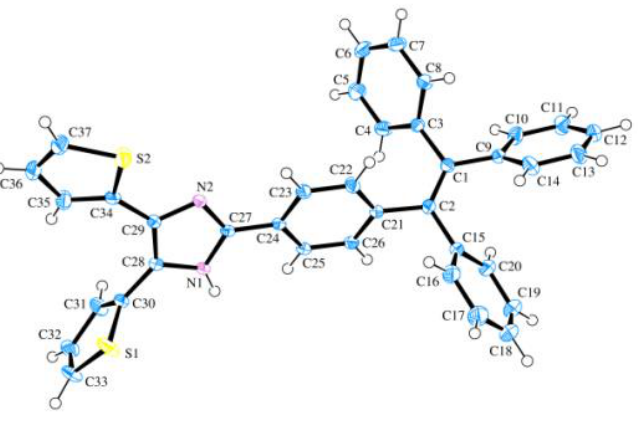
Figure 2. Molecular structure of DTITPE. Ellipsoids show 50% probability levels. The thienyl group containing S1 was disordered (0.749:0.251) by a 180° rotation about the C28 – C30 bond and only the major position is shown.